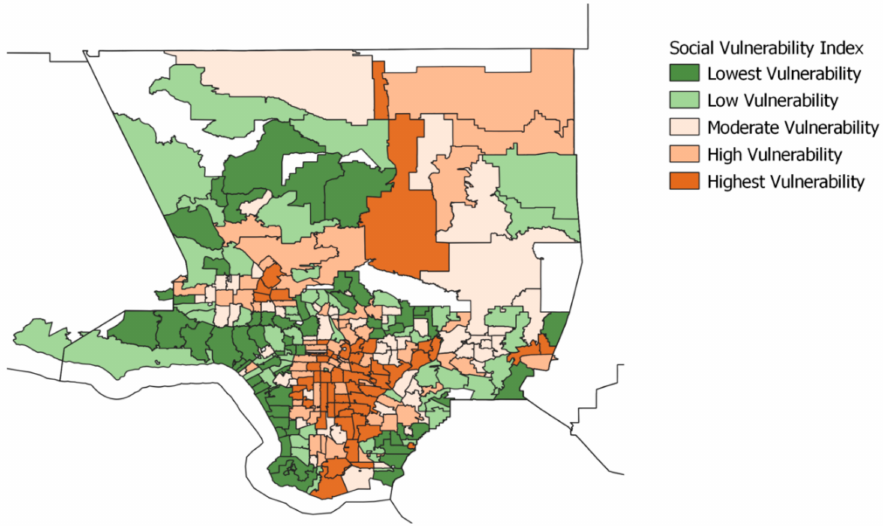
Figure 5. Social vulnerability index, Los Angeles County. This figure captures the social vulnerability index, which identifies vulnerable areas in need of preparation and response to hazardous events or natural disasters. The four components of this index include socioeconomic status, household composition, minority status and language, and housing type and